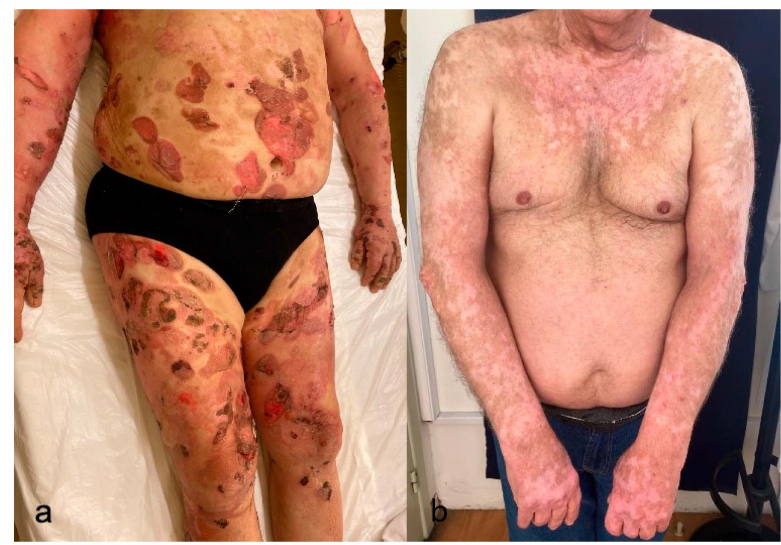
Figure 4. ( a ). ICB-induced bullous pemphigoid ( b ). Vitiligo distributed on sun-exposed